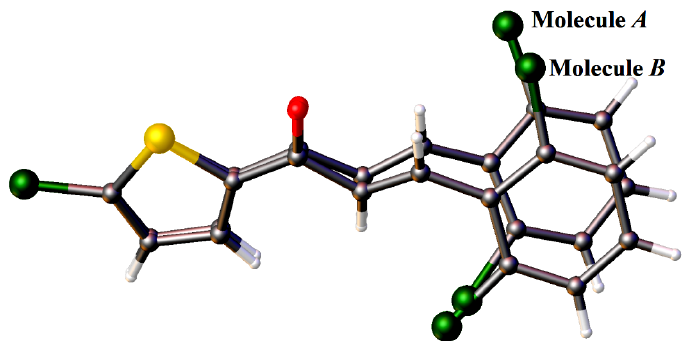
Figure 2. Overlay of molecules A and B in compound 3i , calculated using the chlorothiophene moiety.